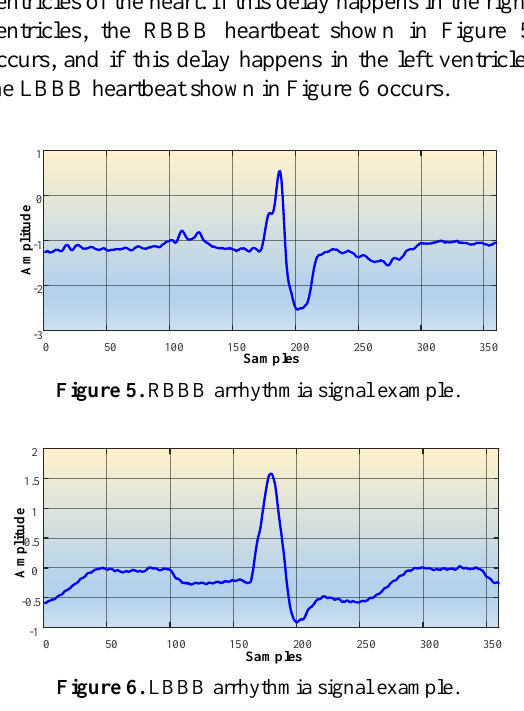
Figure 2. Normal heartbeat ECG signal example.